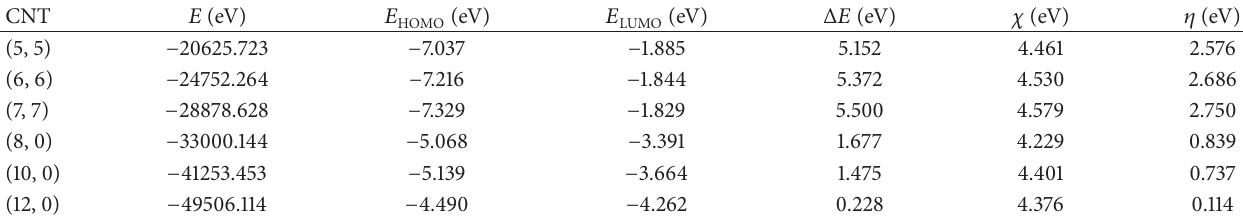
, 𝐸 , band gap, electronegativity, and hardness. HOMO LUMO